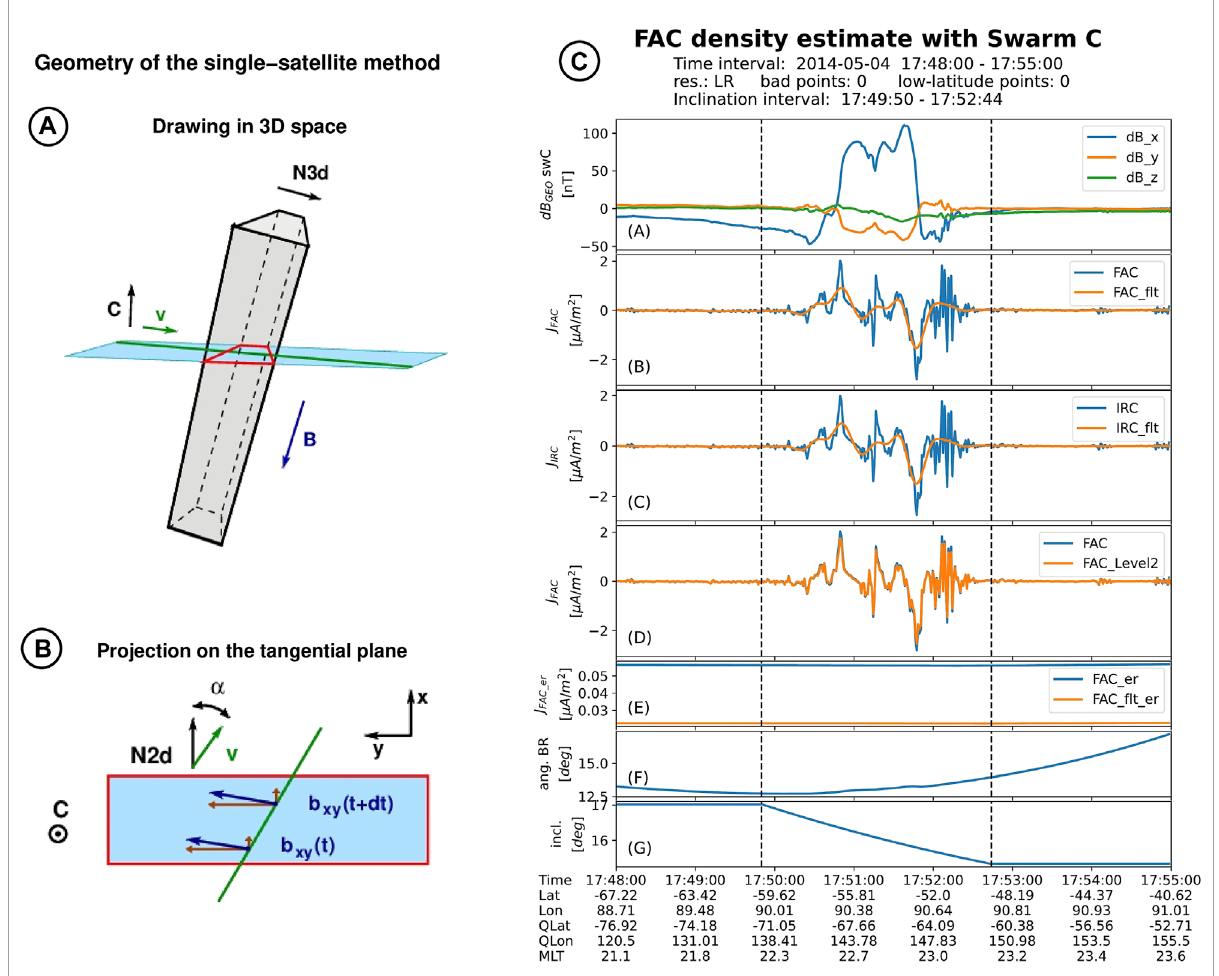
FIGURE 1 FAC density estimate by single-satellite method. (A) : Schematic of a current sheet oriented along the local magnetic field B and normal direction along N3d sampled by a satellite moving with velocity v . (B) : Schematic projection on the plane perpendicular to the local radial direction C . Here b designates the magnetic field perturbation. (C) : Standard plot generated by the j1sat algorithm. From top to bottom the figure shows (A) the Swarm magnetic field perturbation in GEO frame, (B) the un-filtered and filtered FAC densities, (C) the un-filtered and filtered IRC densities, (D) a comparison between FAC estimated with j1sat and the Level-2 product, (E) the errors in un-filtered and filtered FAC densities, (F) the angle between the local magnetic field and the radial direction, and (G) the angle α in the tangential plane between the current sheet normal and the satellite velocity. The labels at the bottom presents time in UTC, the satellite geographic and quasi-dipole latitude and longitude, as well as the magnetic local